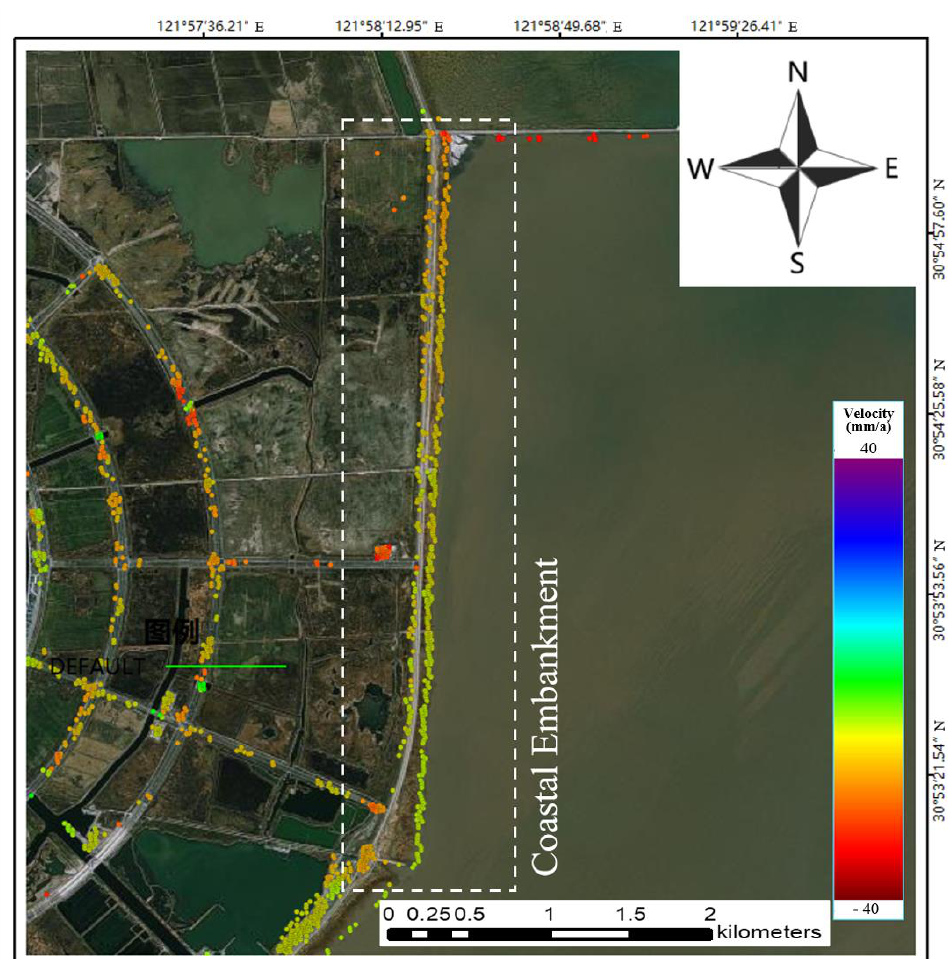
Figure 5. The deformation rate map of the coastal embankment.